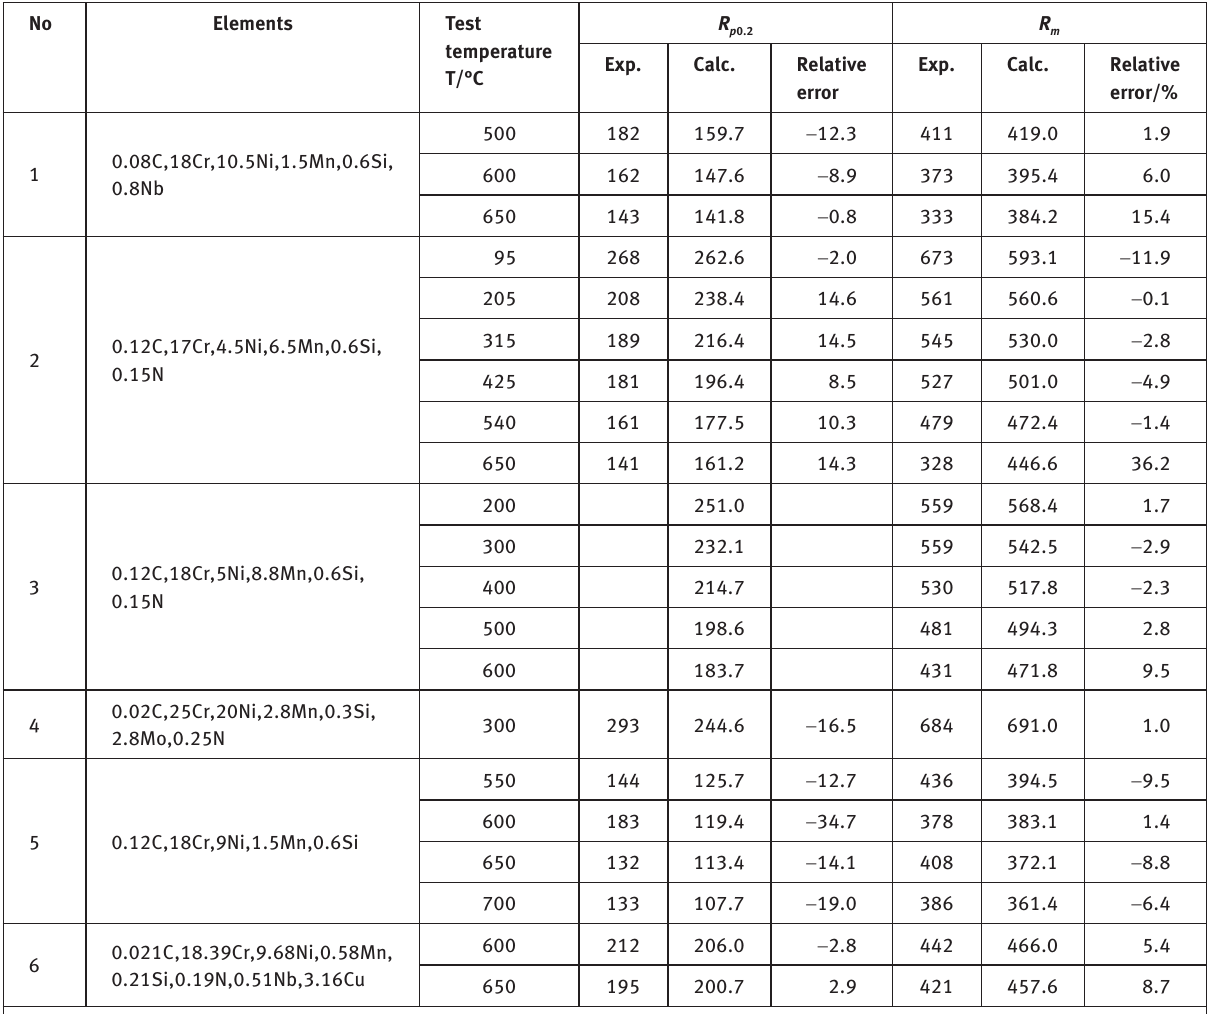
Table 2: The test values and calculated values of austenitic stainless